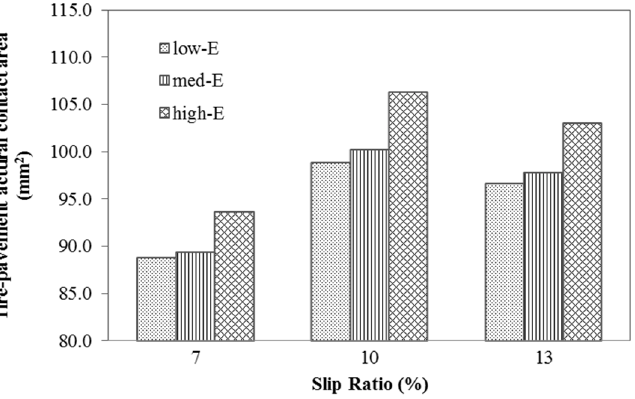
Figure 9. Tire-pavement contact area under different slip ratios.